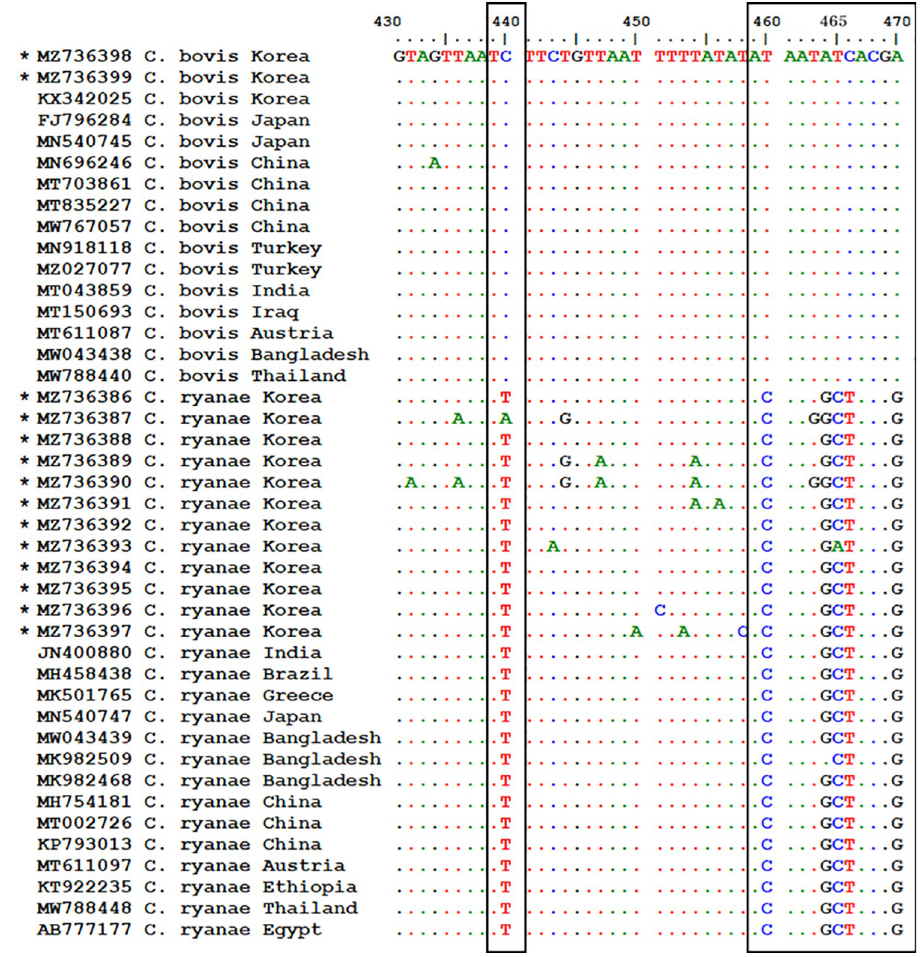
Fig 1. Sequence comparisons between C . bovis and C . ryanae for the partial18S rRNA gene from Korean sequences obtained in this study and reference strains. Six nucleotide differences at 440, 460, 464 − 466, and 470 are shown. An asterisk indicates sequences obtained in this